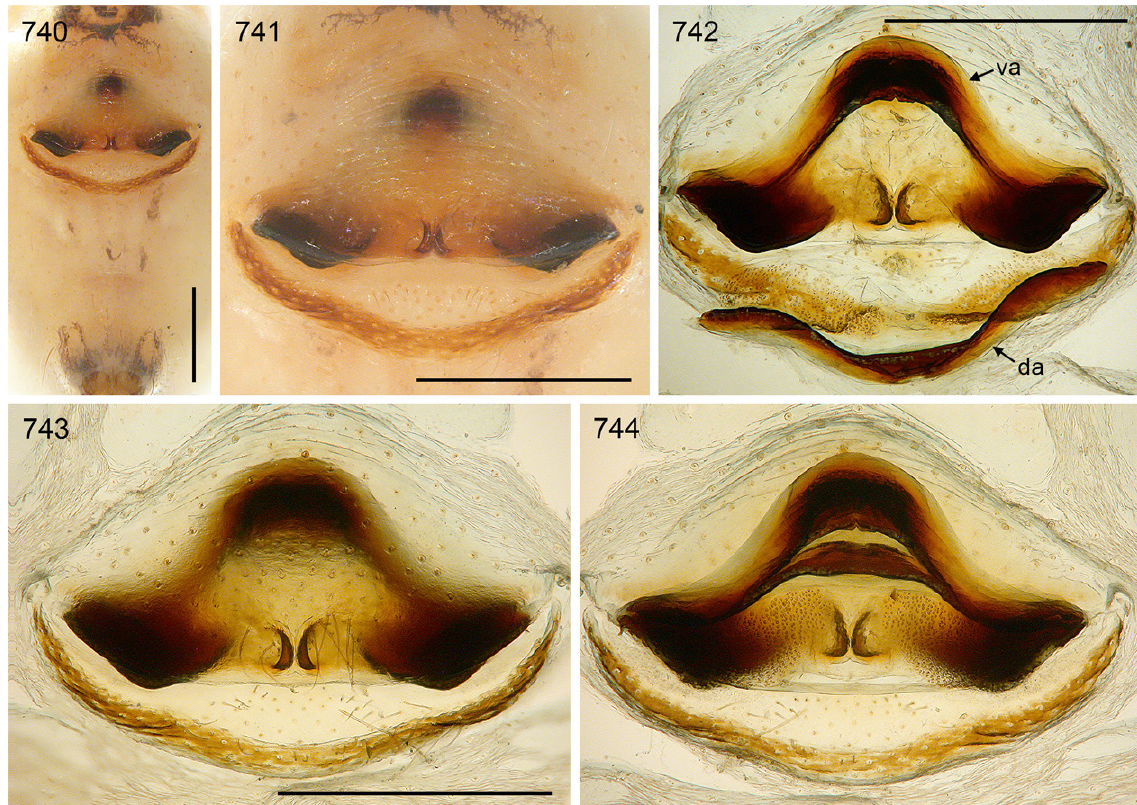
Figs 740–744. Crossopriza parsa sp. nov.; female from Iran, Persepolis (MHNG). 740–741 . Abdomen and epigynum, ventral views. 742–744 . Cleared female genitalia, dorsal view with dorsal arc tilted backwards, ventral view, and regular dorsal view. Scale bars = 0.5